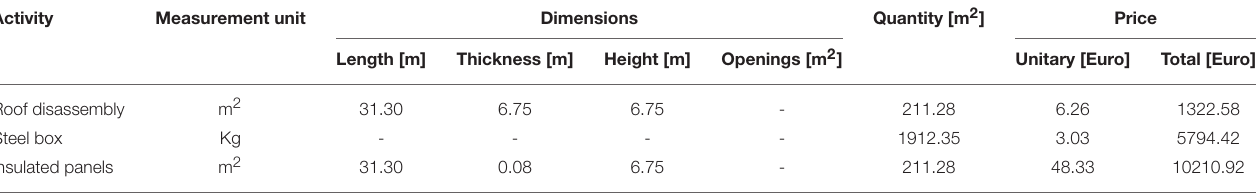
TABLE 7 | Costs of the roof insulation.